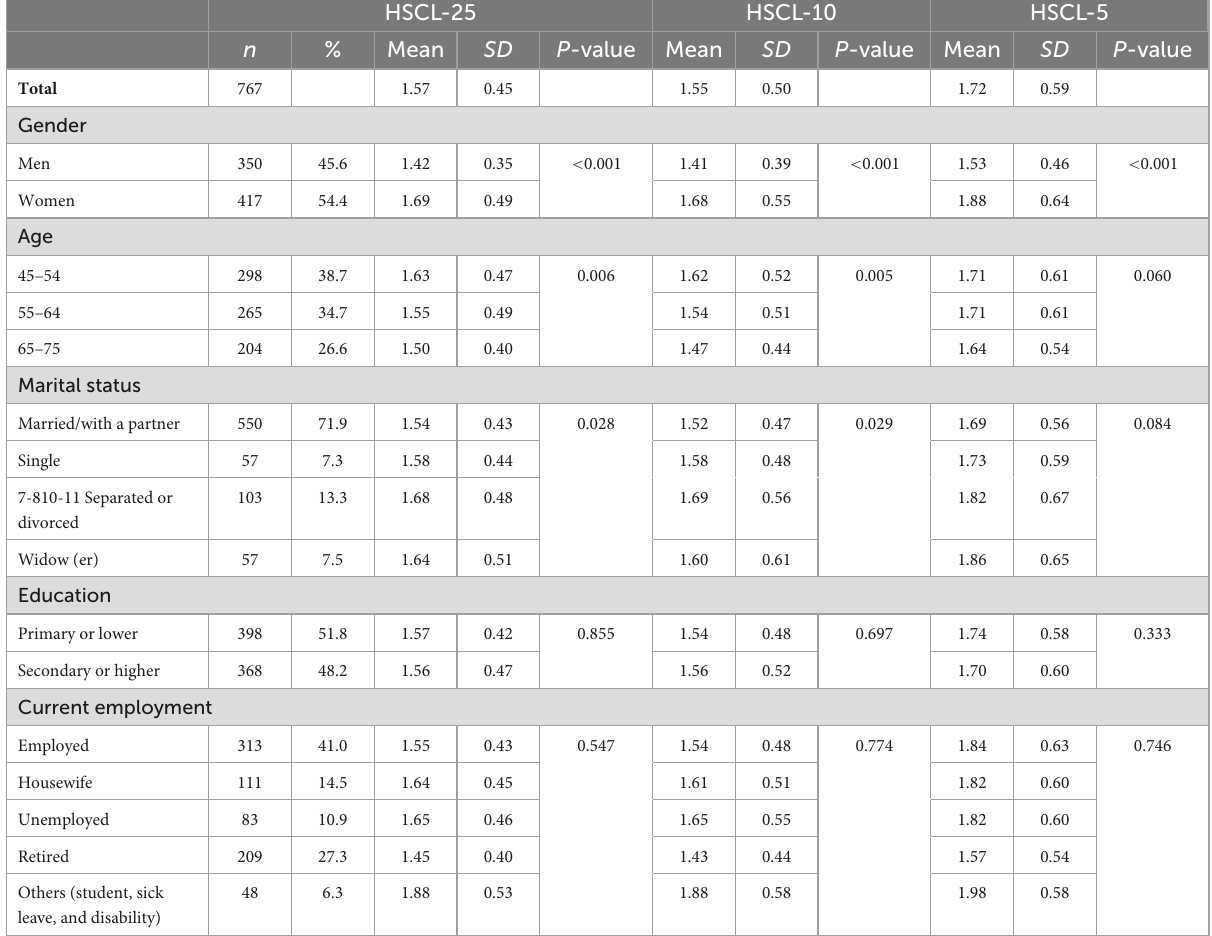
TABLE 2 HSCL-25, HSCL-10, and HSCL-5 scale mean scores and standard deviation (SD) in relation to age, gender, marital status, education, and current